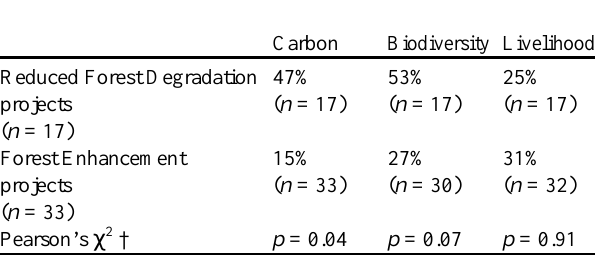
Table 3 . Proportion of Reduced Forest Degradation and Forest Enhancement forest carbon projects validated by the Climate, Community and Biodiversity Alliance (up to April 13, 2012) that involve local stakeholders in monitoring carbon, biodiversity, and